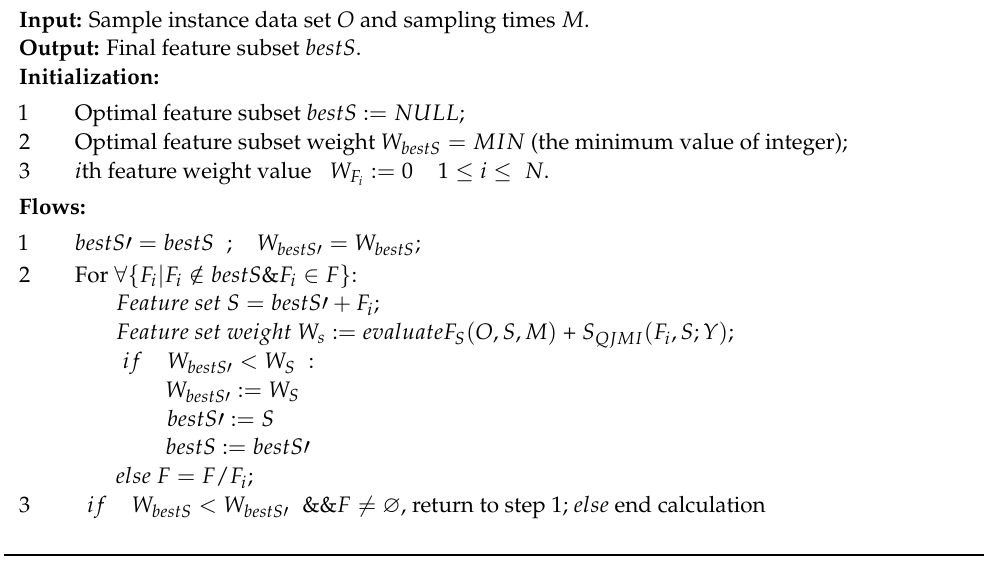
Algorithm 3: FSIRQ (Feature selection algorithm based on Improved Relief and Joint mutual information) feature selection